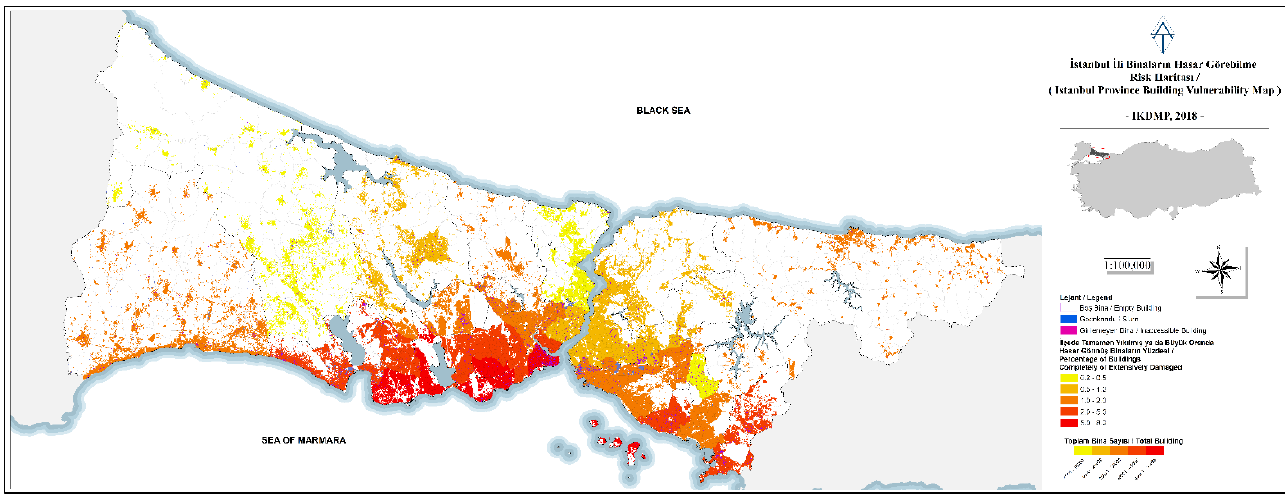
Figure 16. Istanbul Province Building Vulnerability Map (IKDMP, 2018).